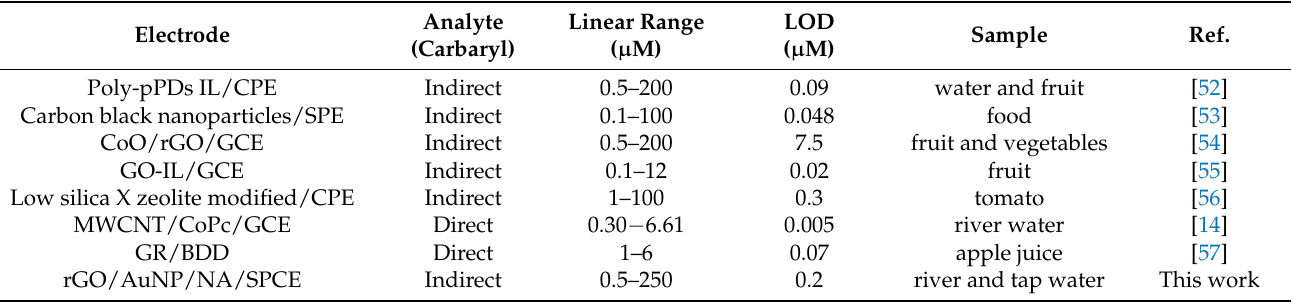
Table 3. Electrochemical analytical performance based on nanocomposites sensor for carbaryl